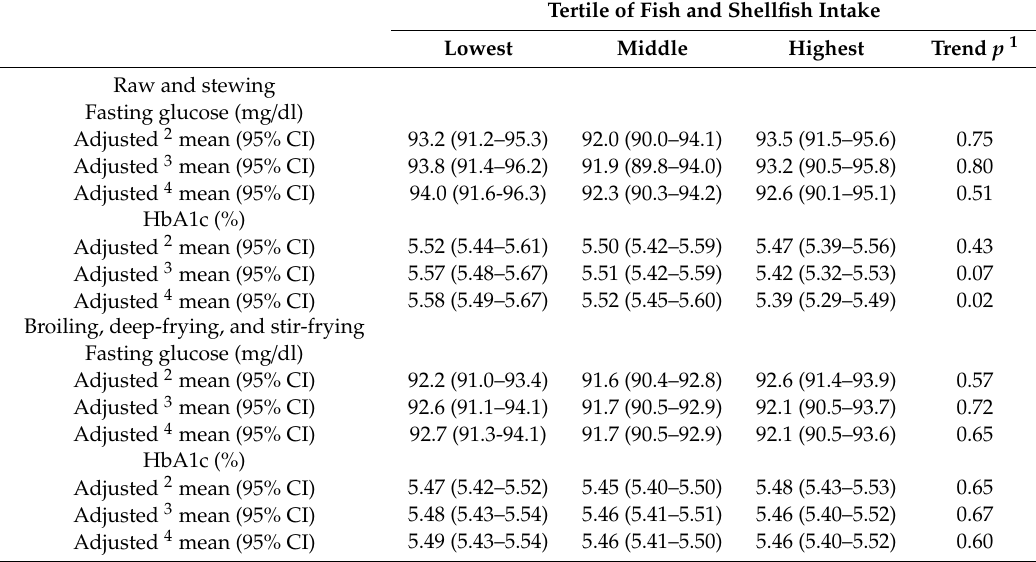
Table 3. Adjusted means (95% CI) of fasting glucose and HbA1c according to tertiles of fish and shellfish intake by fish cooking